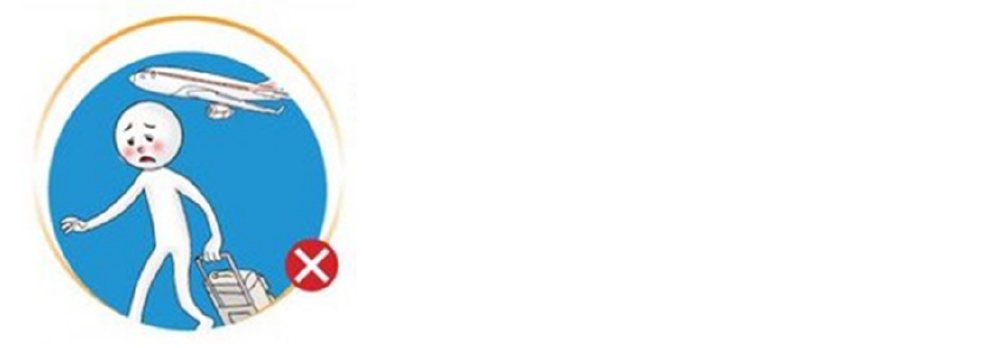
Figure 1. An icon from World Health Organization that intends to convey protocols about travel restriction during the COVID-19 pandemic.